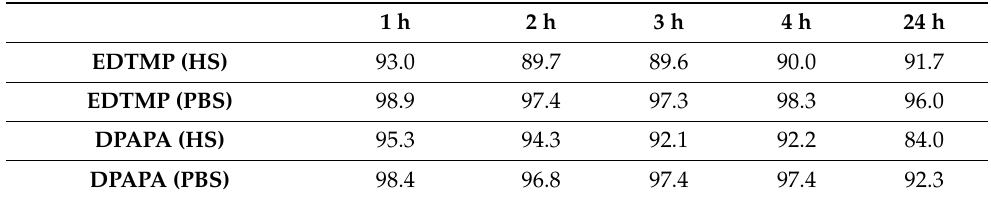
Table 2. Stability of the 44 Sc labeled C-Fe 3 O 4 NC (n =